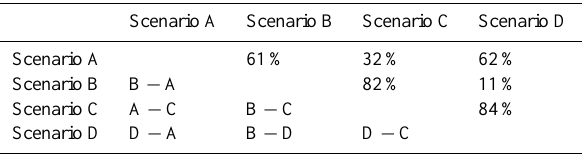
Table 1. Comparison of different scenarios, percentage of flooded areas with significant (i.e. absolute values larger than 10cm) (cid:49)h (i.e. differences between water depths simulated for two Scenar- ios X and Y); “ X − Y” indicates (cid:49)h values computed as water depths simulated for Scenario X minus water depths simulated for Scenario